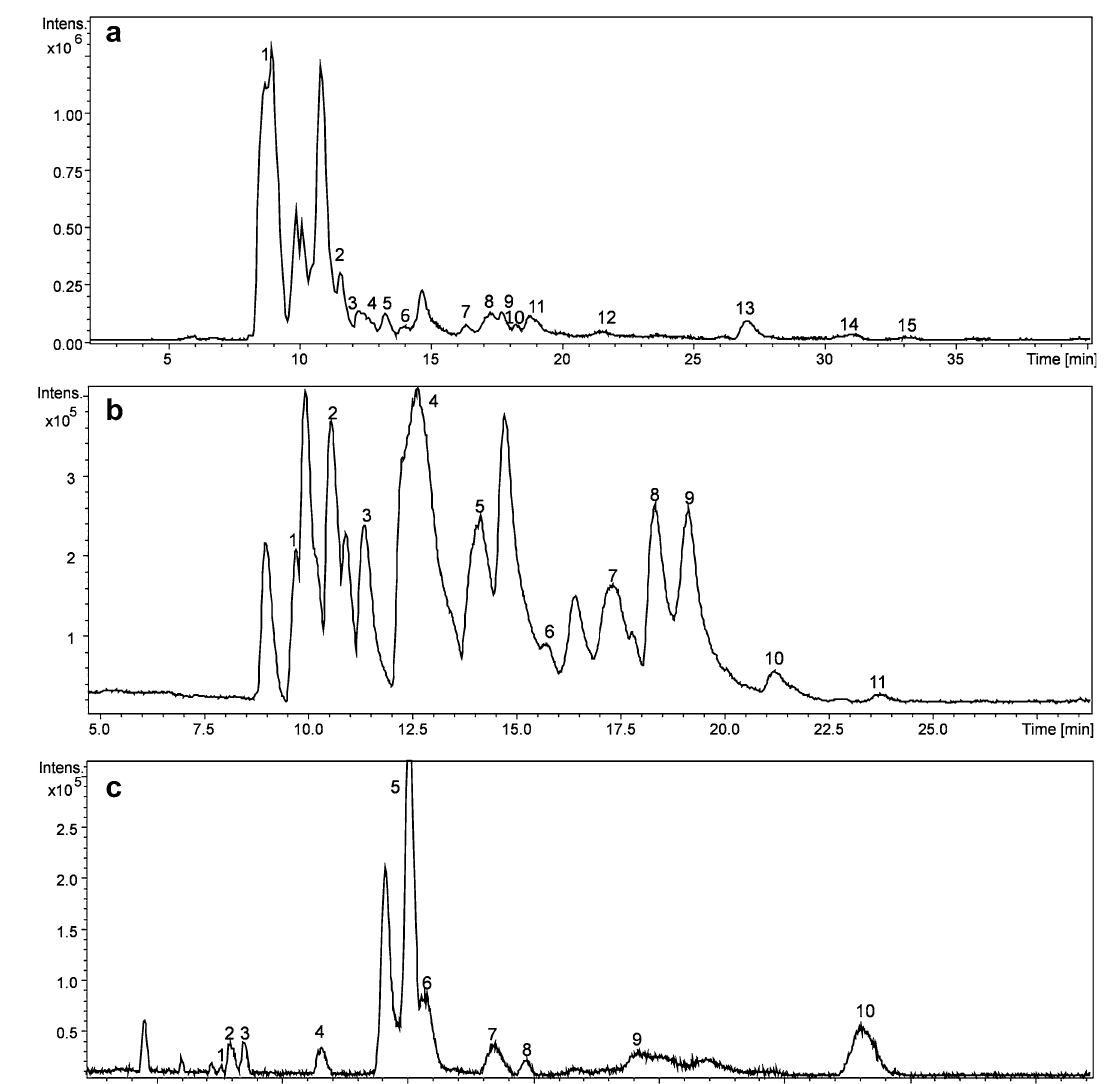
Fig. 3 The BPC of fraction a, b and c analyzed by HPLC–ESI–MS, fifteen, eleven and ten peeks were identified, respectively. Some compounds may flow out at same